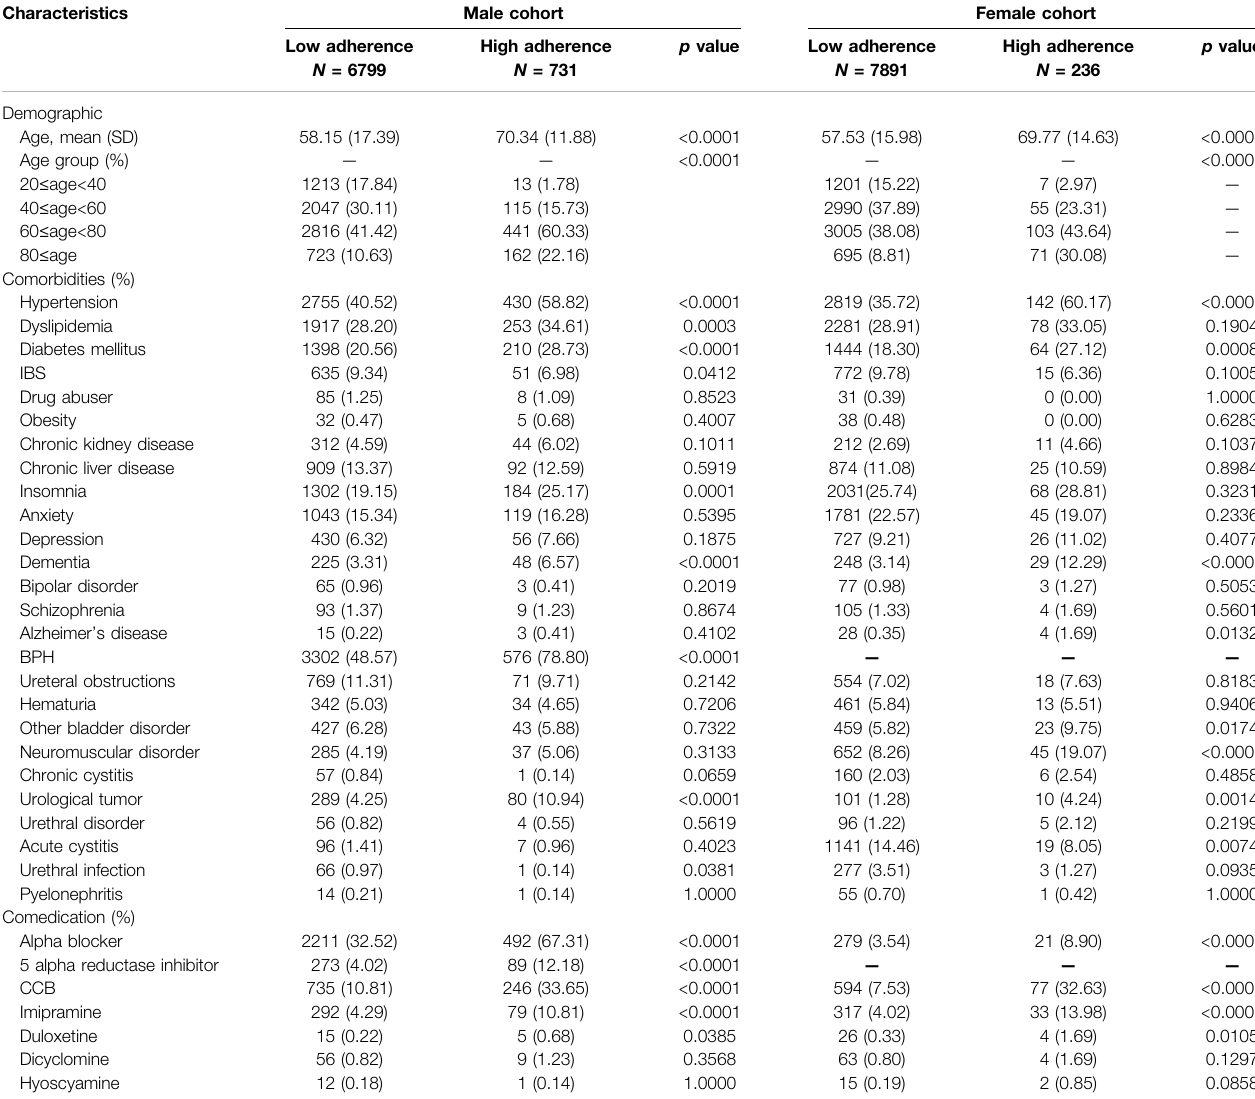
TABLE 2 | Baseline characteristics of the cohort, as strati fi ed by sex and adherence in the never had a UTI history group.